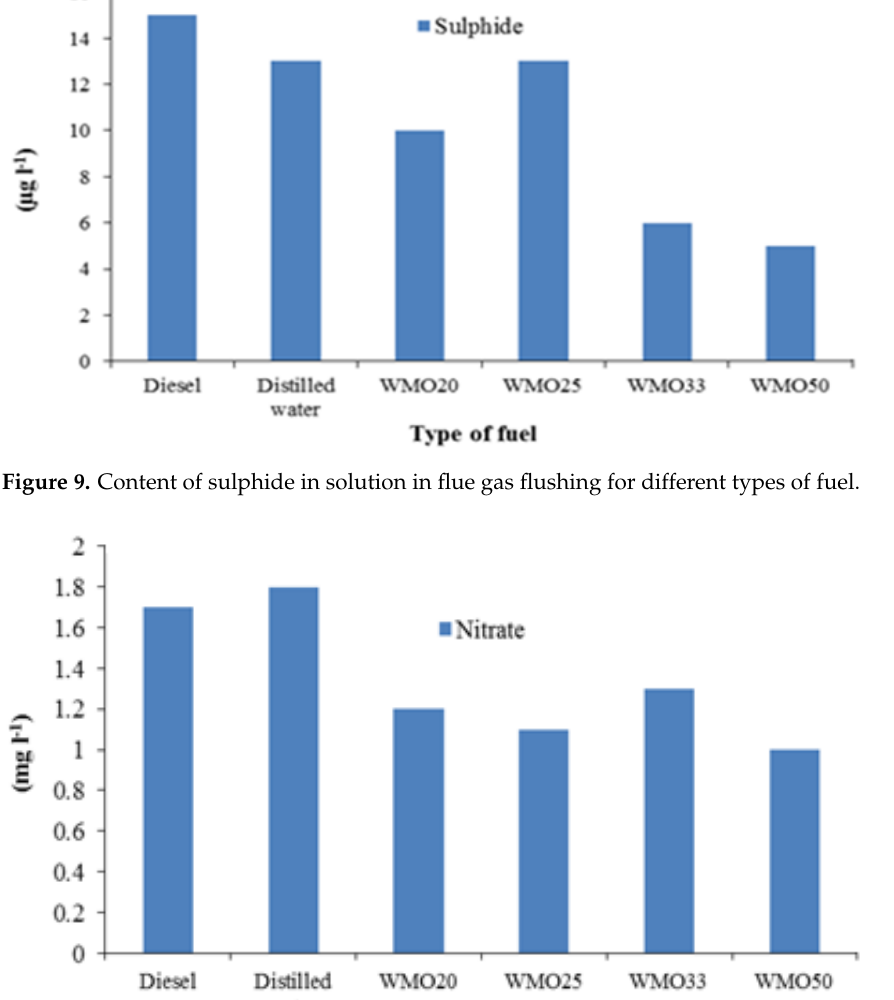
Figure 9. Content of sulphide in solution in flue gas flushing for different types of fuel.